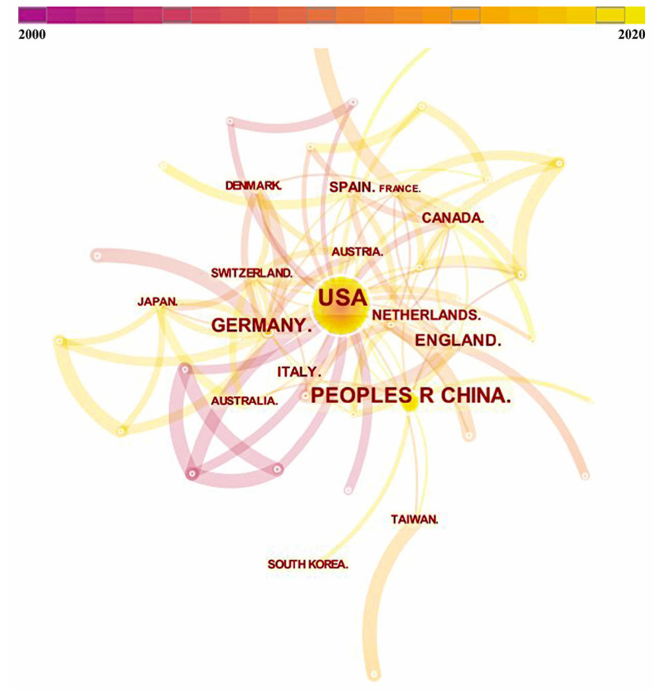
Figure 2. Inter-country cooperation